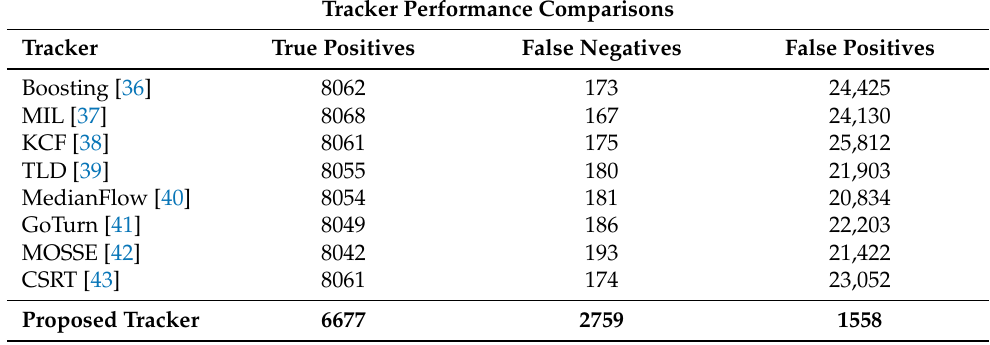
Table A1. Performance using different trackers to condense repeated detections from GPS-RetinaNet. Other methods essentially fail completely to merge repeated detections, since they nearly always predict detections from separate frames are different signs. This occurs because they are not designed to handle large “jumps” in object’s positions and angles between